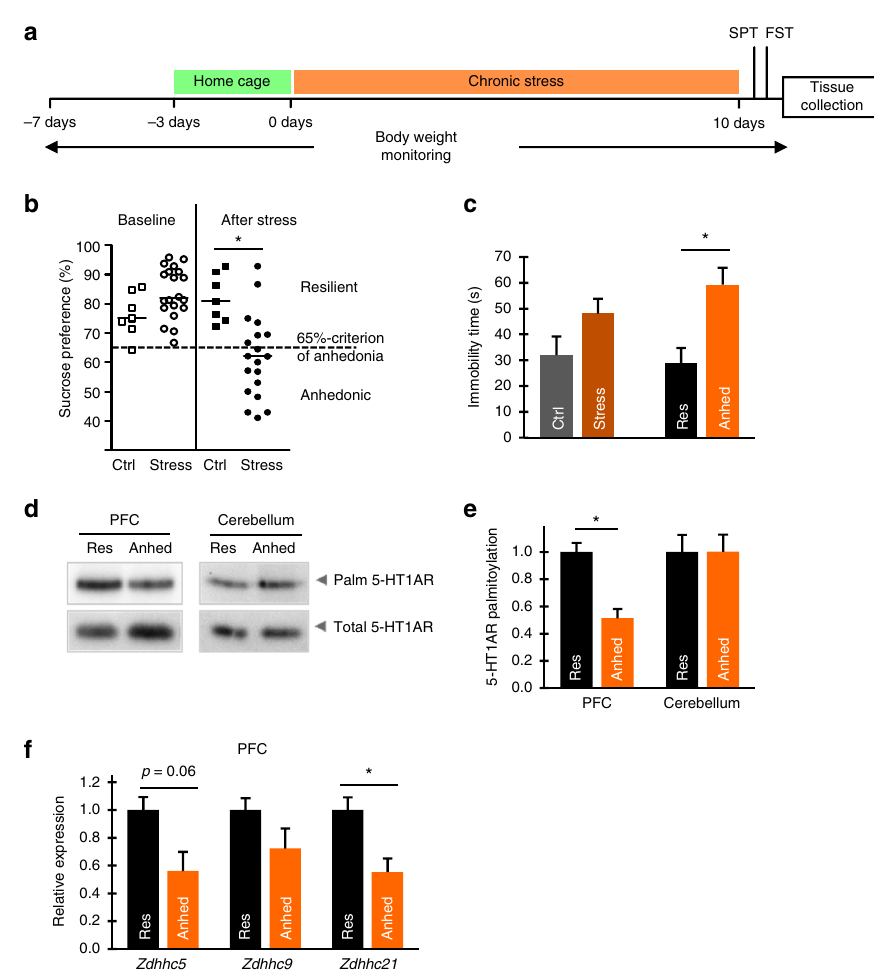
Fig. 3 Palmitoylation of 5-HT1AR and expression of ZDHHC21 are decreased in the forebrains of mice with depressive-like syndrome. a Schematic diagram of experimental design for mouse model of depression. b Results of the sucrose preference test performed in control ( n = 7) and chronically stressed mice ( n = 19). c Immobility time in the forced swim test of control and chronically stressed mice. Group of stressed mice was then divided into anhedonic (anhed) ( n = 12) and resilient (res) ( n = 7) animals and immobility time was analyzed in each subgroup. One-way ANOVA. Data points represent mean ± SEM (* P < 0.05). d In anhedonic and resilient mice, palmitoylation of the 5-HT1AR was analyzed in the prefrontal cortex (PFC) and cerebellum by acyl- biotinyl exchange (see also Supplementary Fig. 5A – E). e Quanti fi cation of 5-HT1AR palmitoylation in anhedonic and resilient animals (see also Supplementary Fig. 5A – E). f Relative expression levels of ZDHHC5, -9, and -21 in the PFC of resilient and anhedonic mice assessed by quantitative reverse transcriptase-PCR. * P < 0.05; two-tailed t test. (See also Supplementary Fig. 5F – H). Source data are available as a Source Data fi